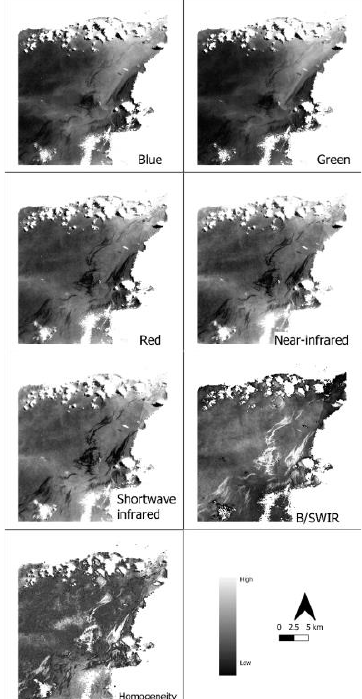
Figure 3. Layers that were transformed to principal